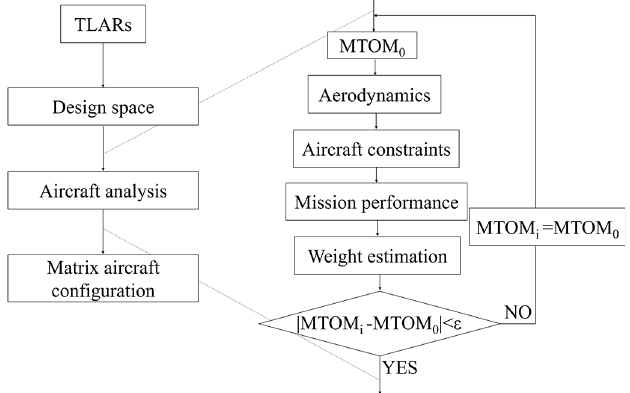
Fig. 3. Work fl ow of